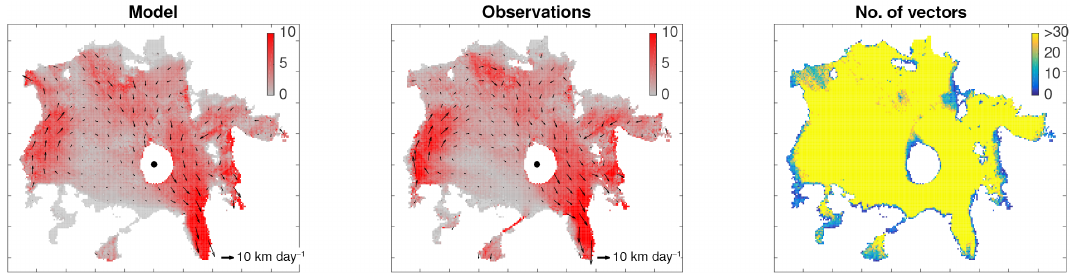
Figure 6. Simulated and observed ice drift averaged over the period between 31 October 2007 and 28 April 2008 (left and middle panels). The number of observations is shown in the right panel. The mean fields are built on a regular grid with a resolution of 21km and are computed by averaging the components of the simulated and observed drift vectors used for the scatter plot. Note that the colour scale for the number of observations is capped at 30 to show that some regions are poorly covered by data.